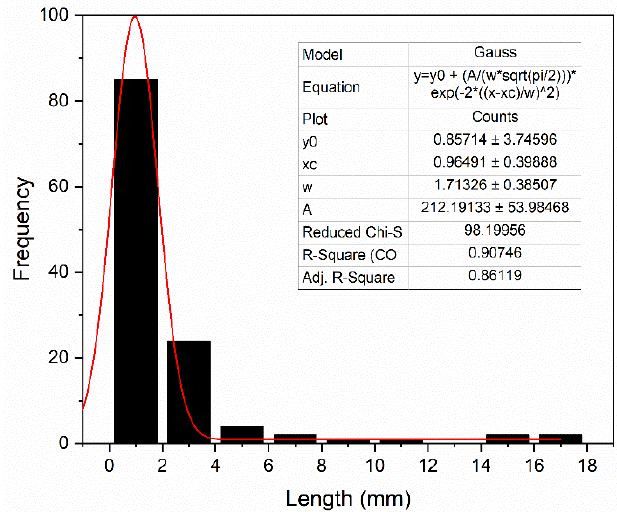
Figure 8. Statistical analysis of crystals with UV assistance. Average size ( xc ) = 0.96